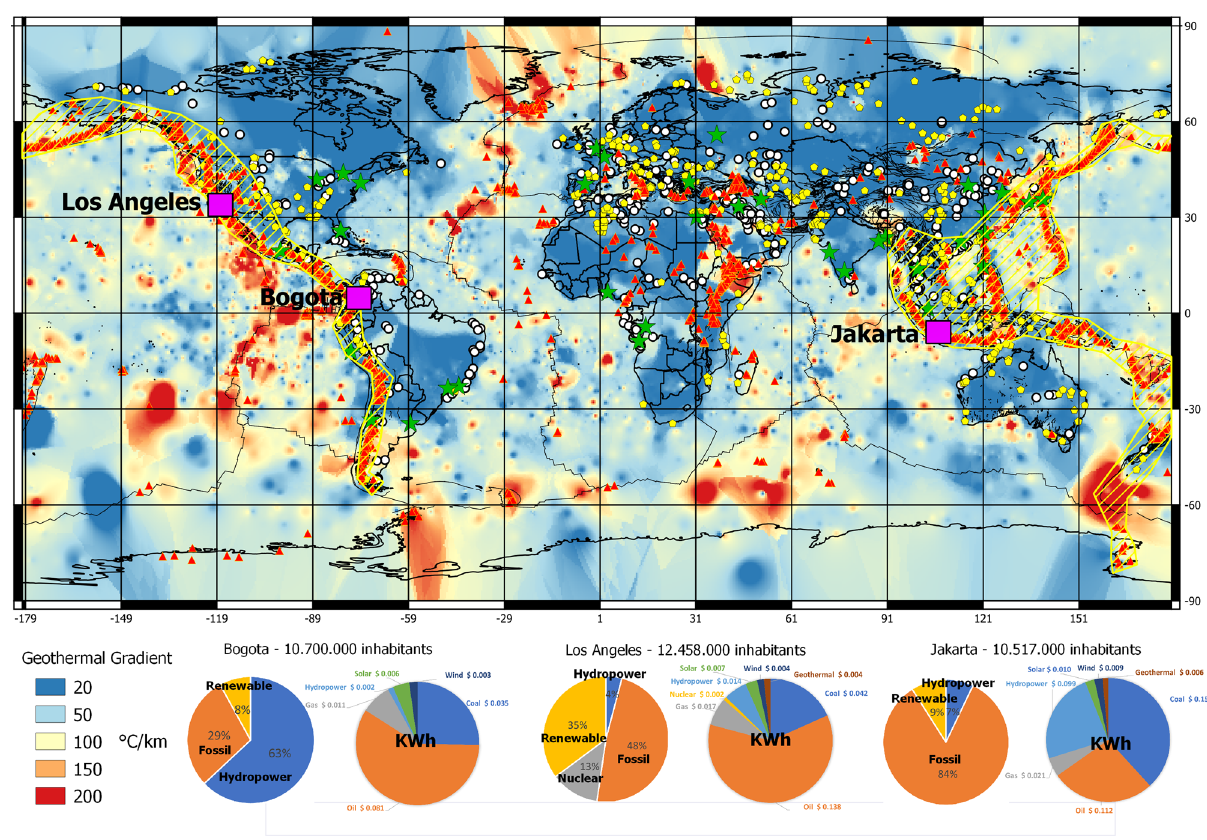
Fig. 1 Worldwide distribution of geothermal gradient anomalies. Locations of volcanic belts (red triangles) and hydrocarbons occurrences (white circles correspond to oil fi elds and yellow pentagons correspond to gas fi elds) have been combined with distribution of megacities (green stars). The ring of fi re is presented as the yellow hatched polygon. Statistics of participation of energy production technologies are shown in the lower panel (left pies), as well as costs of energy production of one kWh (right pies) for Bogotá, Los Angeles, and Jakarta cities (purple squares on the map). Coordinate system in